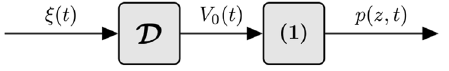
Figure 2. Block diagram of the system under consideration, with input n ð t Þ and output p ð z ; t Þ .